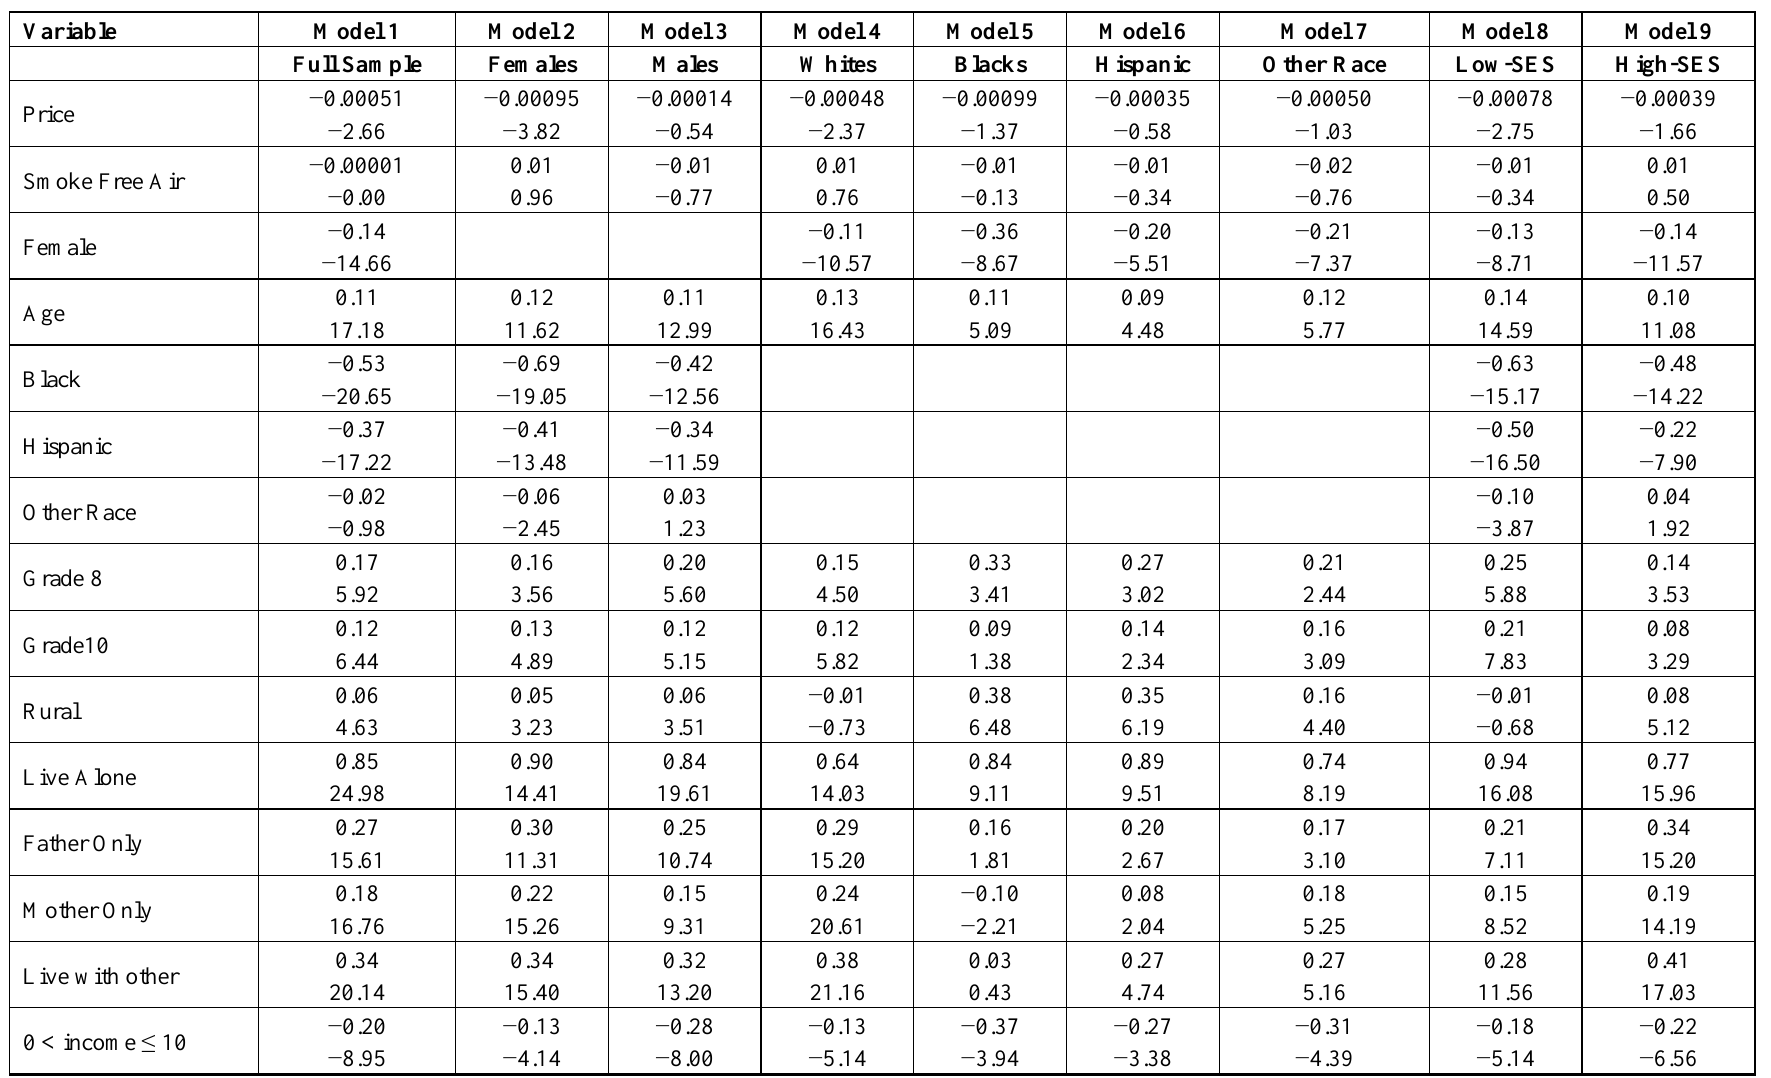
Table 3. Smoking Intensity